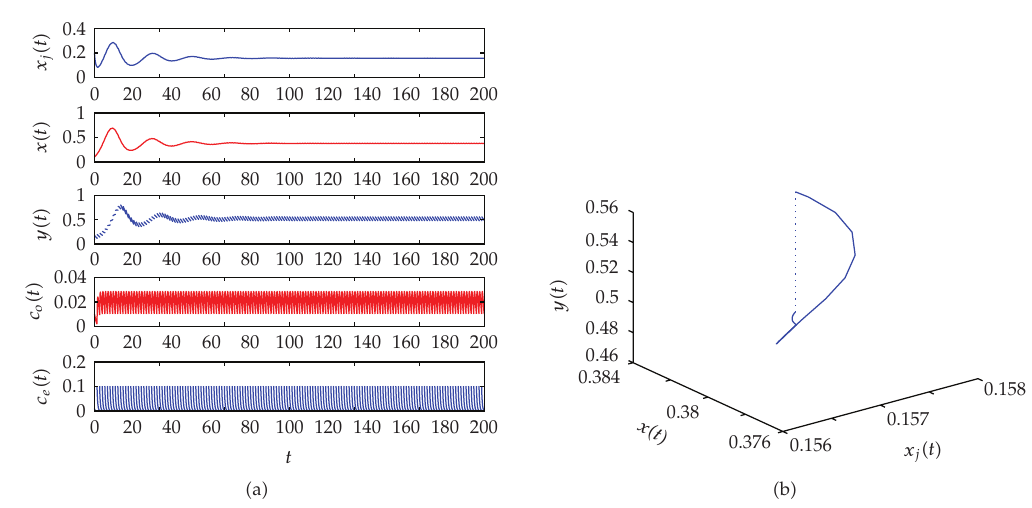
Figure 5: Dynamical behavior (cid:6) permanence (cid:7) of system (cid:6) 2.1 (cid:7) with a (cid:8) 0 . 8, b 1 (cid:8) 0 . 9, τ (cid:8) 0 . 7, f (cid:8) 0 . 2, β (cid:8) 0 . 9, η (cid:8) 1, r (cid:8) 0 . 7, b 2 (cid:8) 0 . 3, λ (cid:8) 0 . 9, k (cid:8) 1, g (cid:8) 0 . 5, m (cid:8) 0 . 7, h (cid:8) 2, l (cid:8) 0 . 1, T (cid:8) 2, μ 2 (cid:8) 0 . 1, initial values x j (cid:6) 0 (cid:7) (cid:8) 0 . 2, x (cid:6) 0 (cid:7) (cid:8) 0 . 1, y (cid:6) 0 (cid:7) (cid:8) 0 . 1, c o (cid:6) t (cid:7) (cid:8) 0 . 01, c e (cid:6) t (cid:7) (cid:8) 0 . 01 (cid:6) ∗ corresponding theoretical criteria value: μ ∗∗ Time series of system (cid:6) 2.1 (cid:7) with μ 1 (cid:8) 0 . 08. (cid:6) b (cid:7) Solution x j (cid:6) t (cid:7) , x (cid:6) t (cid:7) , y (cid:6) t (cid:7) with μ 1 (cid:8) 0 . 08 will finally tend to a T -periodic solution.